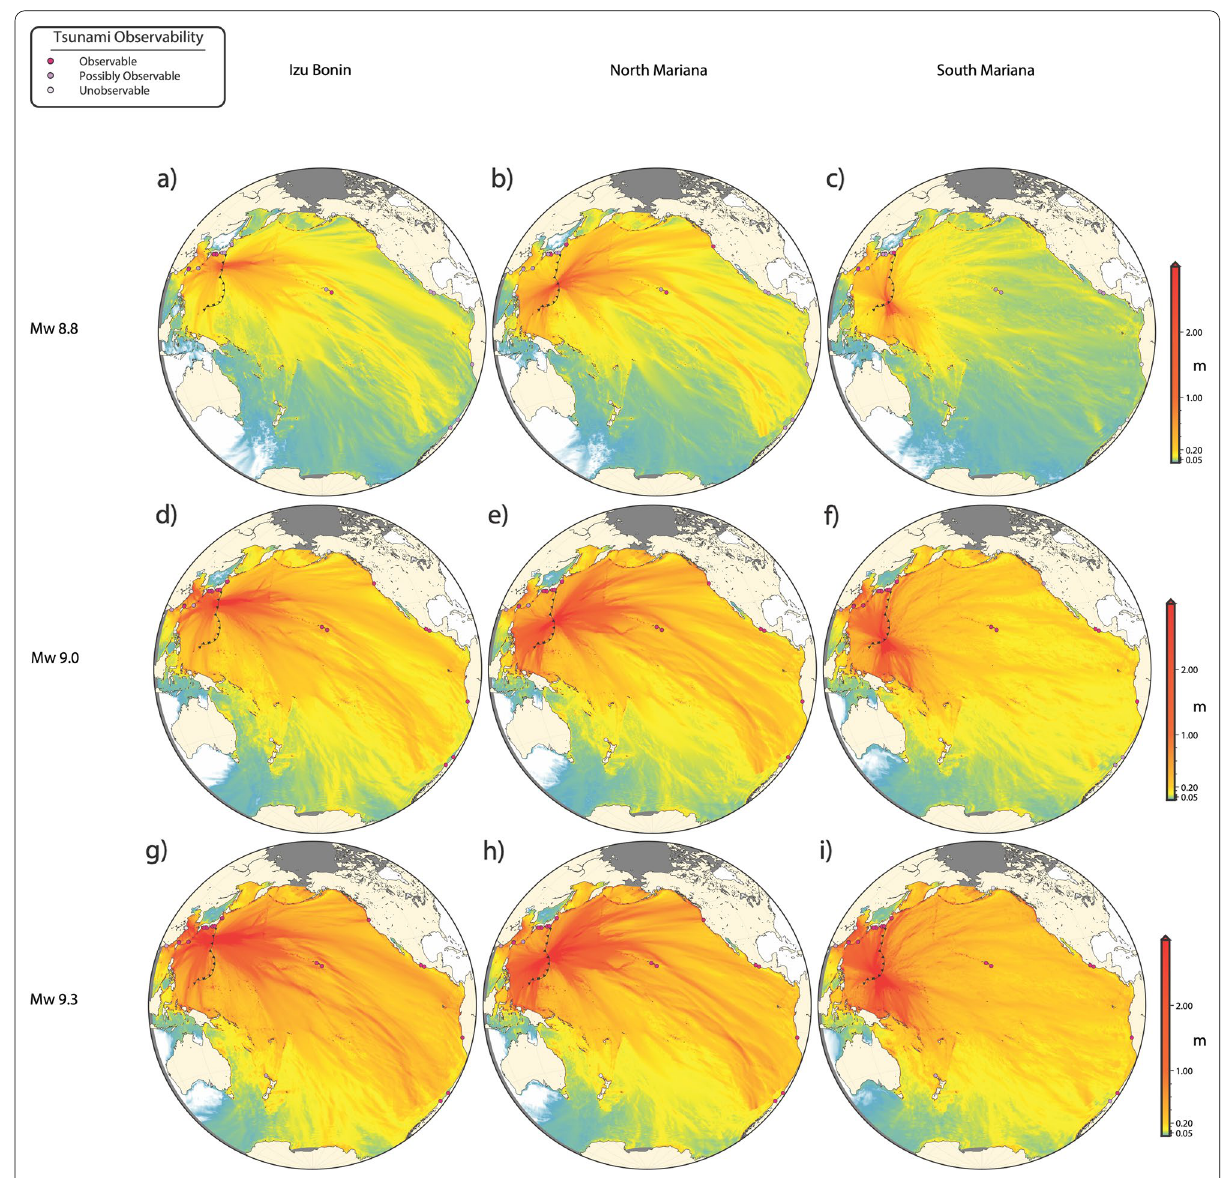
Fig. 3 Maximum wave height and tsunami observability for earthquake scenarios in the Izu–Bonin–Mariana subduction system. Figures a-c show maximum wave heights for earthquakes of magnitude M w 8.7 for the Izu–Bonin (a), North Mariana (b), and South Mariana (c) sources. Figures d-f show maximum wave heights for earthquakes of magnitude M w 9.0 for the Izu–Bonin (d), North Mariana (e), and South Mariana (f) sources. Figures g-I show maximum tsunami wave heights for magnitude M w 9.3 earthquakes for the Izu–Bonin (g), North Mariana (h), and South Mariana (i). Filled circles represent tsunami visibility with the darkest purple indicating maximum wave heights in excess of the local tidal range, medium purple representing maximum wave heights larger than 30% of the local tidal range, and the lightest purple indicating maximum wave heights less than 30% of the local tidal range. All plots use the same color scale for maximum wave